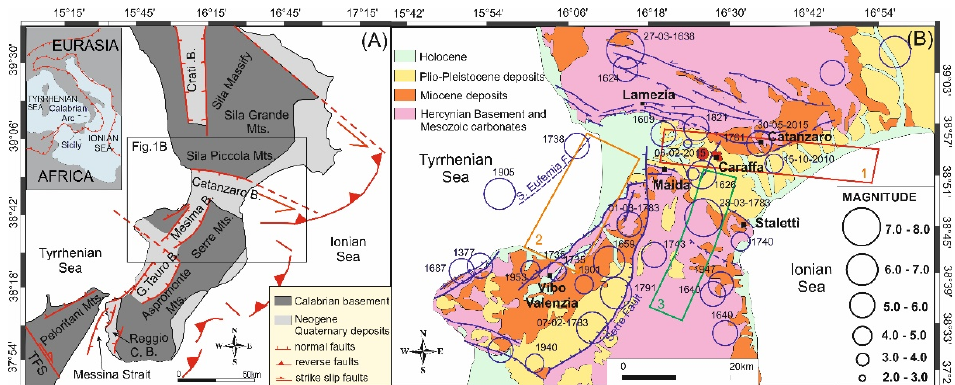
Figure 1. ( A ) Simplified map showing the main structural elements of the Calabrian Arc (from 9 modified). TFS, Tindari Fault System. Inset shows the central Mediterranean orogen in the context of the Eurasia–Africa convergence. ( B ) Geological map of the Catanzaro Trough and the surrounding area showing Quaternary faults from the literature (see Figure 1A for location). Circles are the historical and instrumental epicentres of earthquakes with a magnitude higher than 4.8 (CPTI,14); red balls represent the seismic sequence of October 2019; rectangles are modelled seismogenic sources: 1, ITCS068; 2, ITCS110 (from the database of the DISS Working Group [15]); 3, ITES002 (from Akingi et al. [13]).